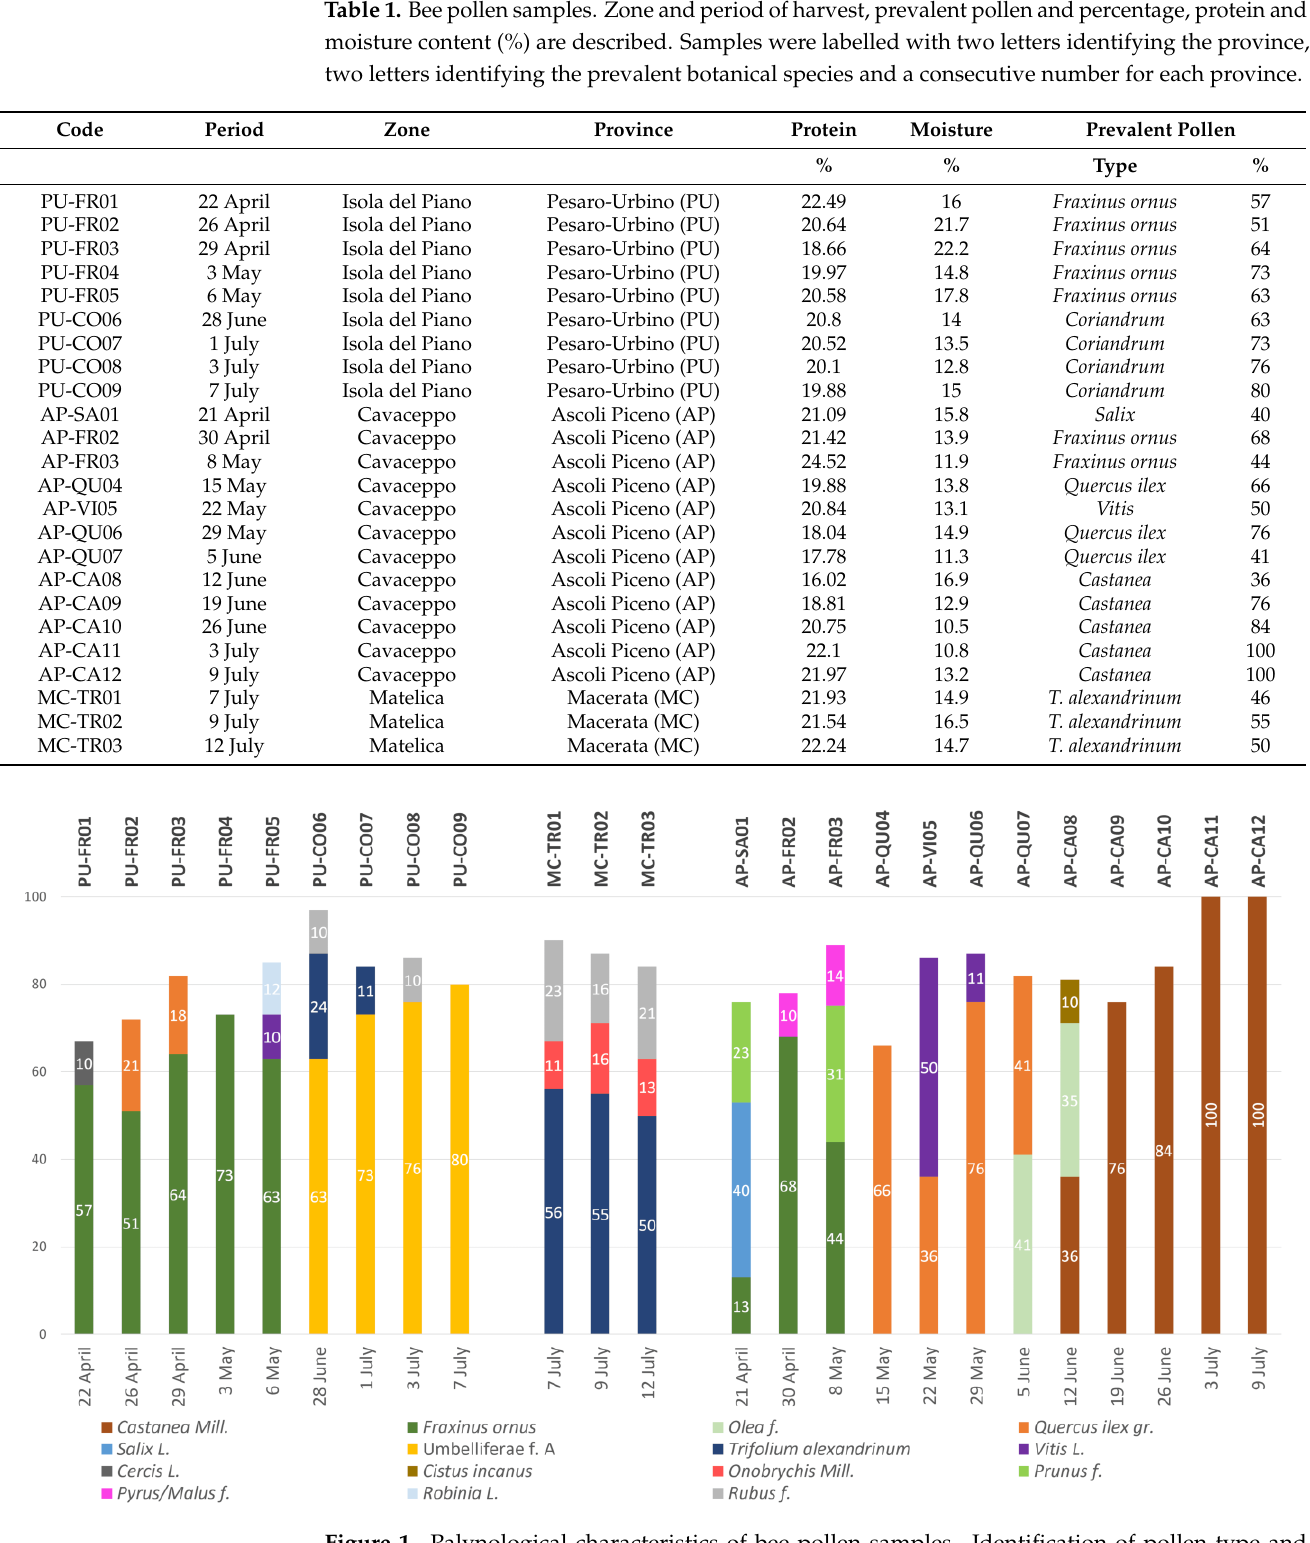
Figure 1. Palynological characteristics of bee pollen samples. Identification of pollen type and percentage (prevalence > 10 %), of harvesting zone (code) and period for each pollen sample are provided. The botanical species was also determined using the knowledge on the territory’s flora, the cultivation maps and beekeepers’